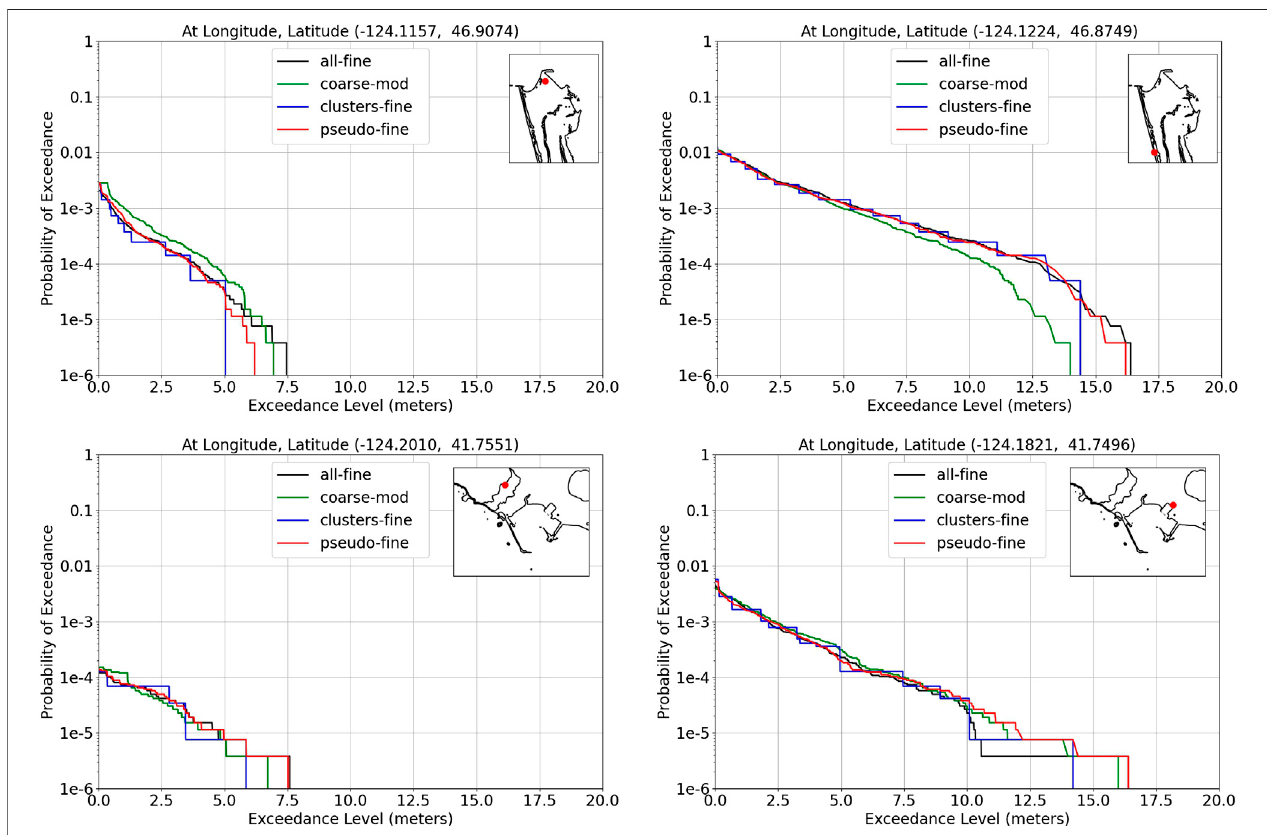
FIGURE 10 | Sample hazard curves at two locations in Westport (top) and two locations in Crescent City (bottom) , in each case indicated by the dots in the inset maps. The curves show the reference all- fi ne result p f ( (cid:1) h ) and three approximate hazard curves p cm ( (cid:1) h ) , p cf ( (cid:1) h ) , and p pf ( (cid:1) h ) as de fi ned in Section 6 .